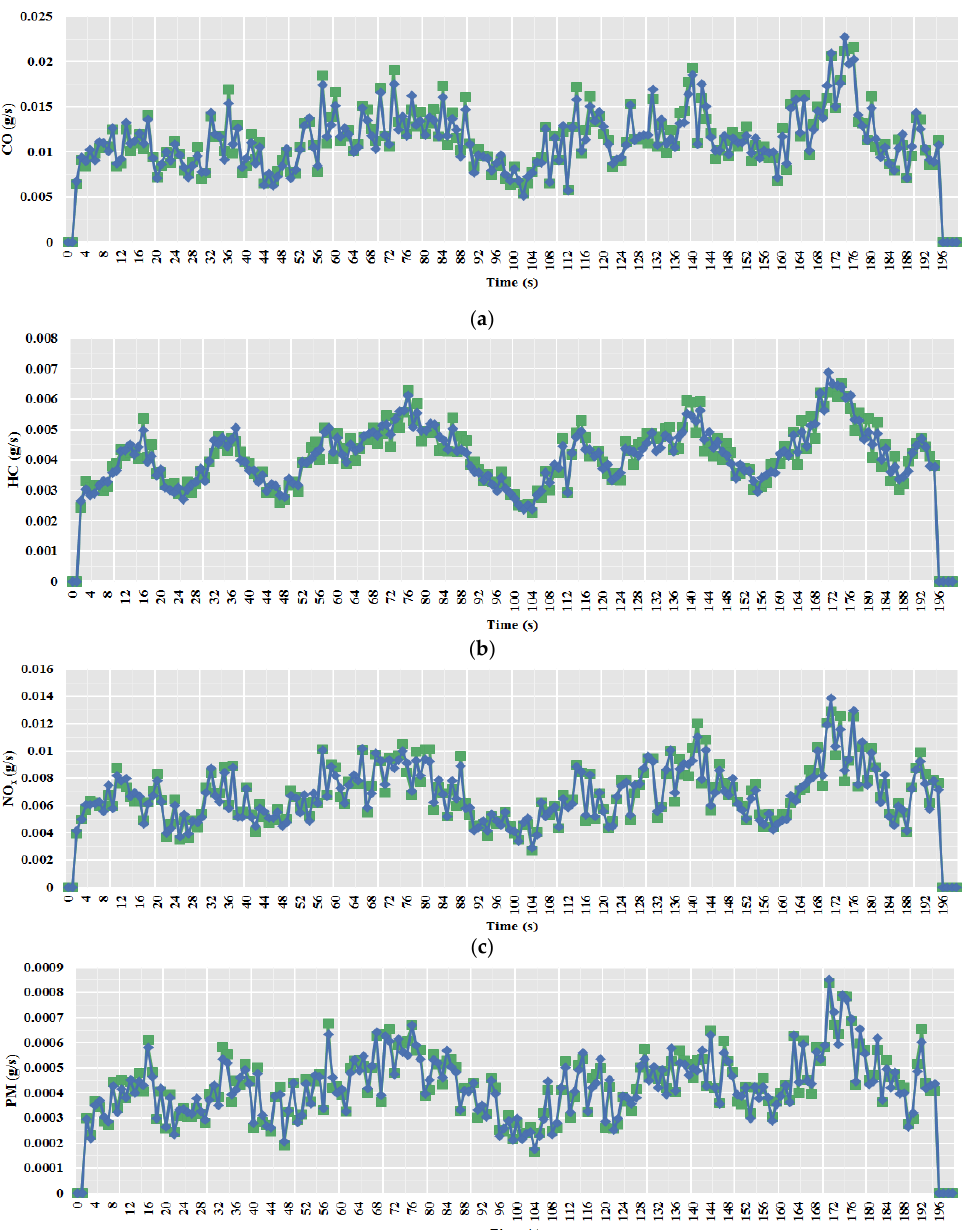
Figure 15. Comparison of measurement and simulation values of instantaneous pollutant emission rate under the driving condition for validation; ( a ) Comparison of measurement and simulation values of in-stantaneous CO emission rate; ( b ) Comparison of measurement and simulation values of instantaneous HC emission rate; ( c ) Comparison of measurement and simulation values of instanta- neous NOx emission rate; ( d ) Comparison of measurement and simulation values of instantaneous PM emission